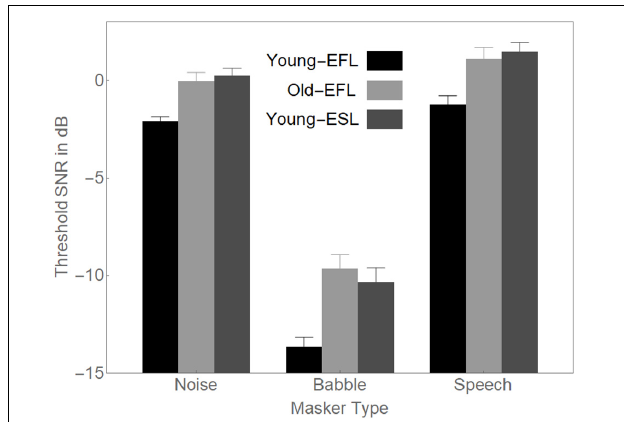
FIGURE 4 | Average 50% thresholds in Noise, Babble, and Speech for the three groups of participants. Error bars are standard errors of the means.